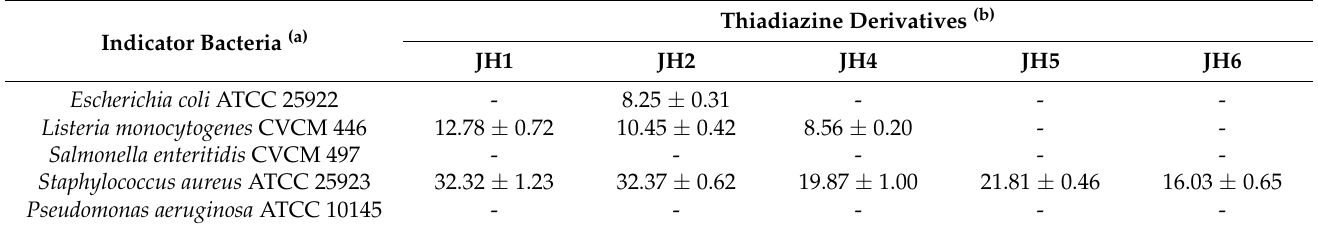
Table 4. Antimicrobial activity of bis-THTT’ ‘s (JH1, JH2, JH4, JH5 and JH6) on Gram-positive and Gram-negative